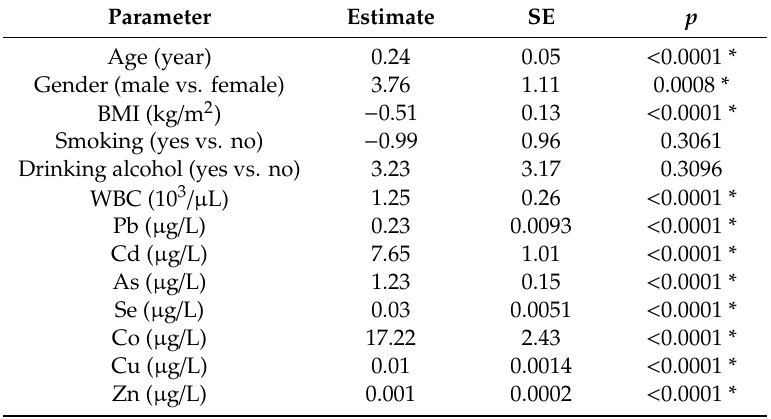
Table 3. Mixed-e ff ect model of the association of covariates with serum TNF- α